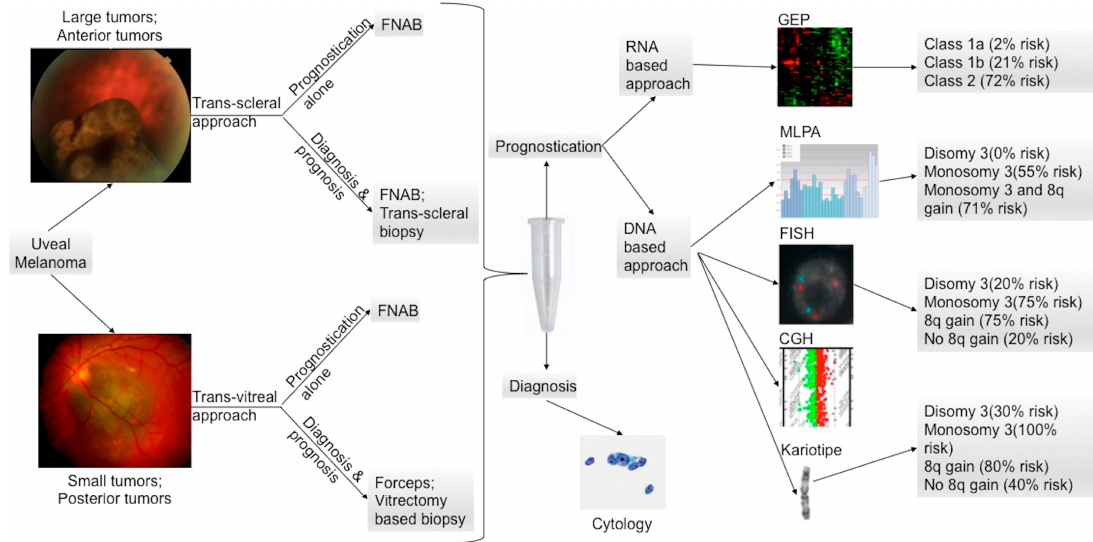
Figure 10. Posterior uveal melanoma prognostic test flow-chart modified from Schopper et al. [85]. Large and anterior tumors are commonly biopsied using a trans-scleral approach, whereas posterior tumors and small tumors are better reached by a transvitreal approach. When possible, FNAB (fine needle aspiration biopsy) should be used because it is considered to be the less invasive technique. Current prognostic tests rely on either DNA or RNA extraction from tumor specimens. FISH (fluorescence in situ hybridization), CGH (comparative genomic hybridization), MLPA (multiplex ligation-dependent probe amplification), and karyotyping are the most common used techniques for the DNA analysis. GEP (gene expression profiling) is the preferred technique for the RNA-based prognostication. An estimated 10-year metastasis-free survival is listed based on publications on the karyotype analysis [86], FISH [87], and MLPA [88]. An estimated 5-year metastasis-free survival based on GEP classification is also listed [89].